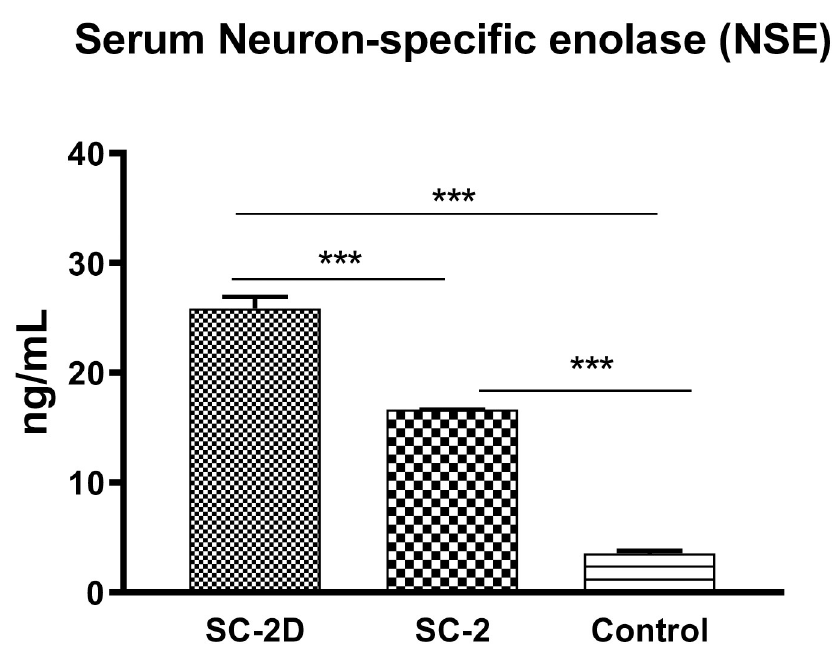
Fig 2. Neuron-Specific Enolase (NSE) serum levels. Clinical biochemistry data on NSE in Group 1: SC-2D, Group 2: SC-2, and Group 3: Control. Results are shown as mean ± SD. The analysis of variance test was performed to evaluate the differences between groups. ��� P < 0.01. P values remained significant after Bonferroni comparisons (P < 0.01).